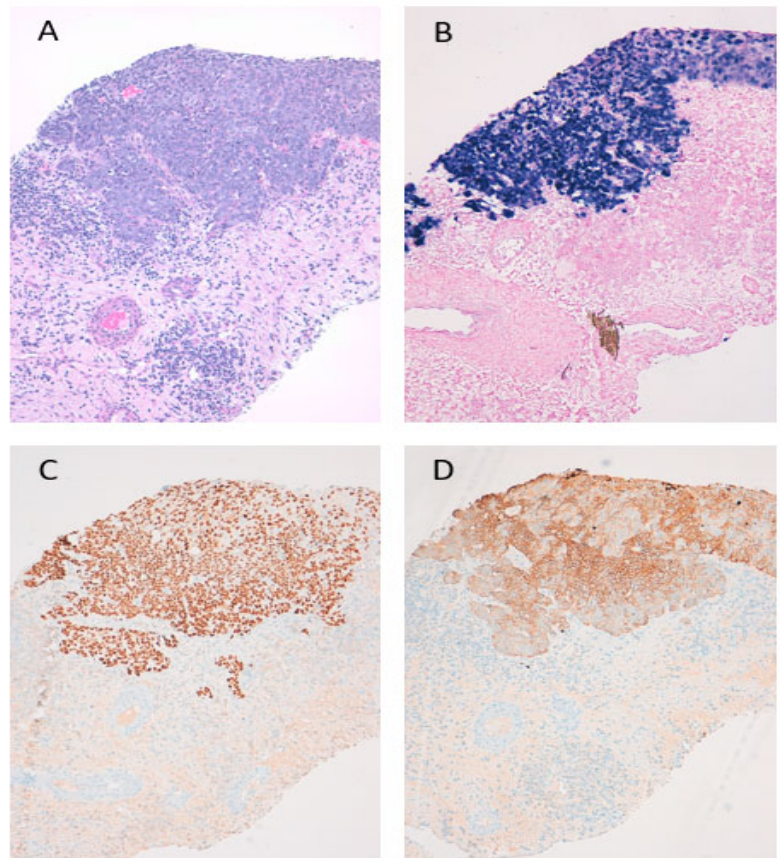
Figure 1. Histology reveals a poorly differentiated carcinoma with syncytial growth pattern and dense lymphocytic infiltrate ( A ). In situ hybridisation for EBV-encoded small RNA (EBER) selectively labels the carcinoma cells, while the lymphoid cells are negative ( B ), proving infection with Epstein- Barr-Virus (EBV). The tumour cells show diffuse staining for p40 ( C ) and cytokeratin 5/6 ( D ), both indicating squamous differentiation.